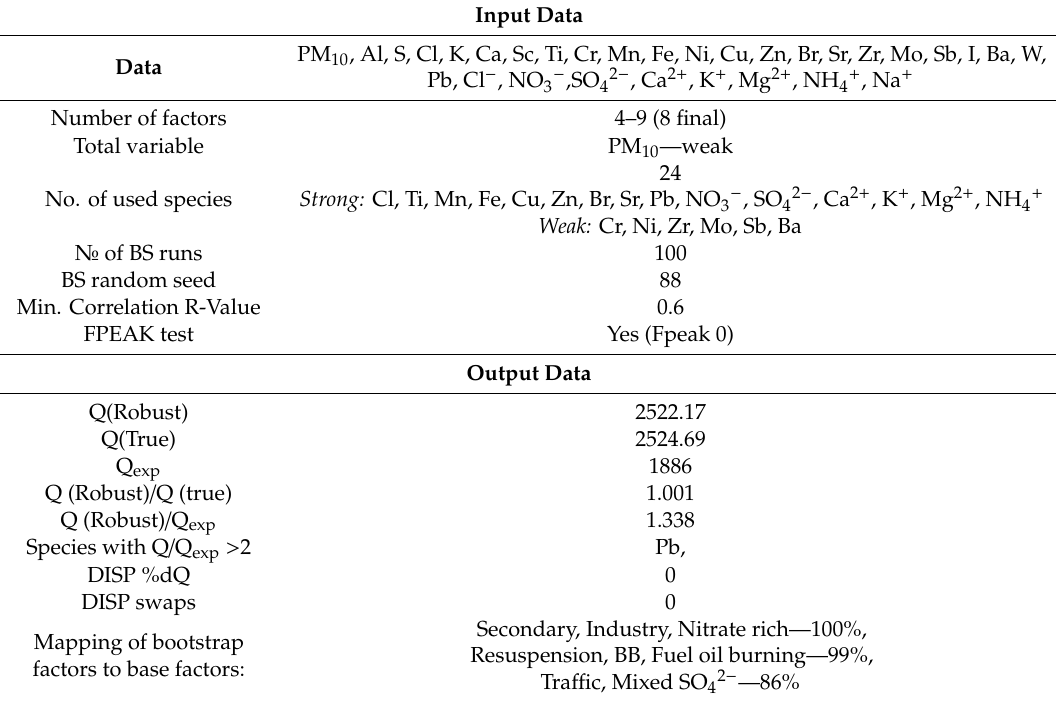
Table 2. Summary of the Positive Matrix Factorization (PMF) input and output